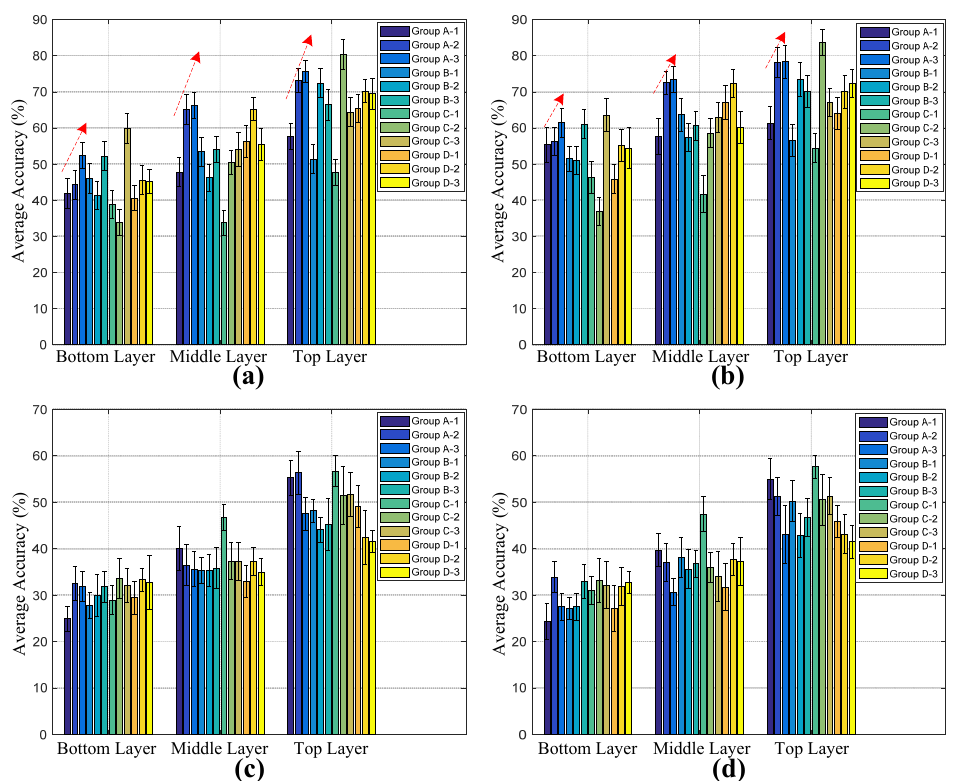
Figure 9. Average accuracy and standard deviation with respect to different dual-links. ( a ) VQ with LOS; ( b ) HMM with LOS; ( c ) VQ with NLOS; ( d ) HMM with